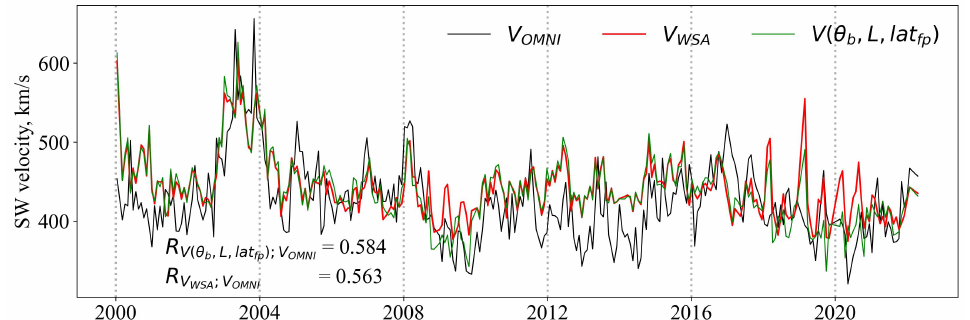
Figure 5. An example of a three-parameter dependence of SW velocity V ( θ b , L , lat fp ) comparison with the observed velocity V OMNI and with the velocity calculated according to the WSA model V WSA . Calculations using the CR-averaged